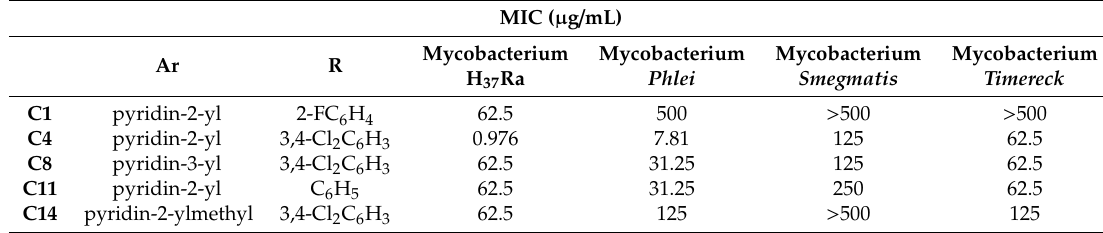
Table 4. Minimal inhibitory concentration for compounds C1–C14